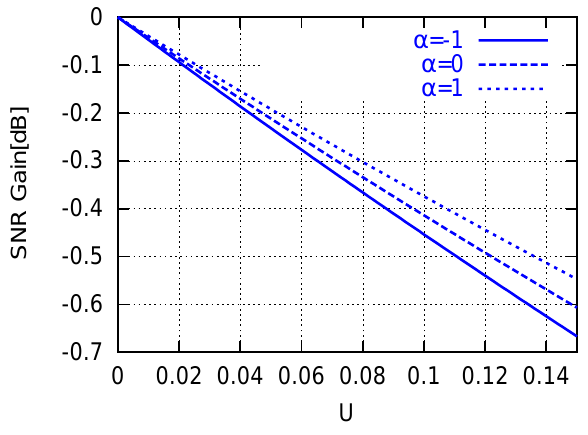
Fig. 6. SNR loss as a function of constrained norm value U